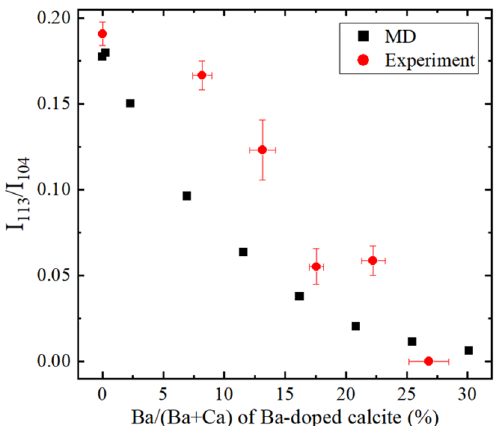
Figure 10. Ba concentration in calcite versus reflection intensities of 113 normalized by 104 (I 113 / I 104 ) obtained from the MD simulation and experiments.